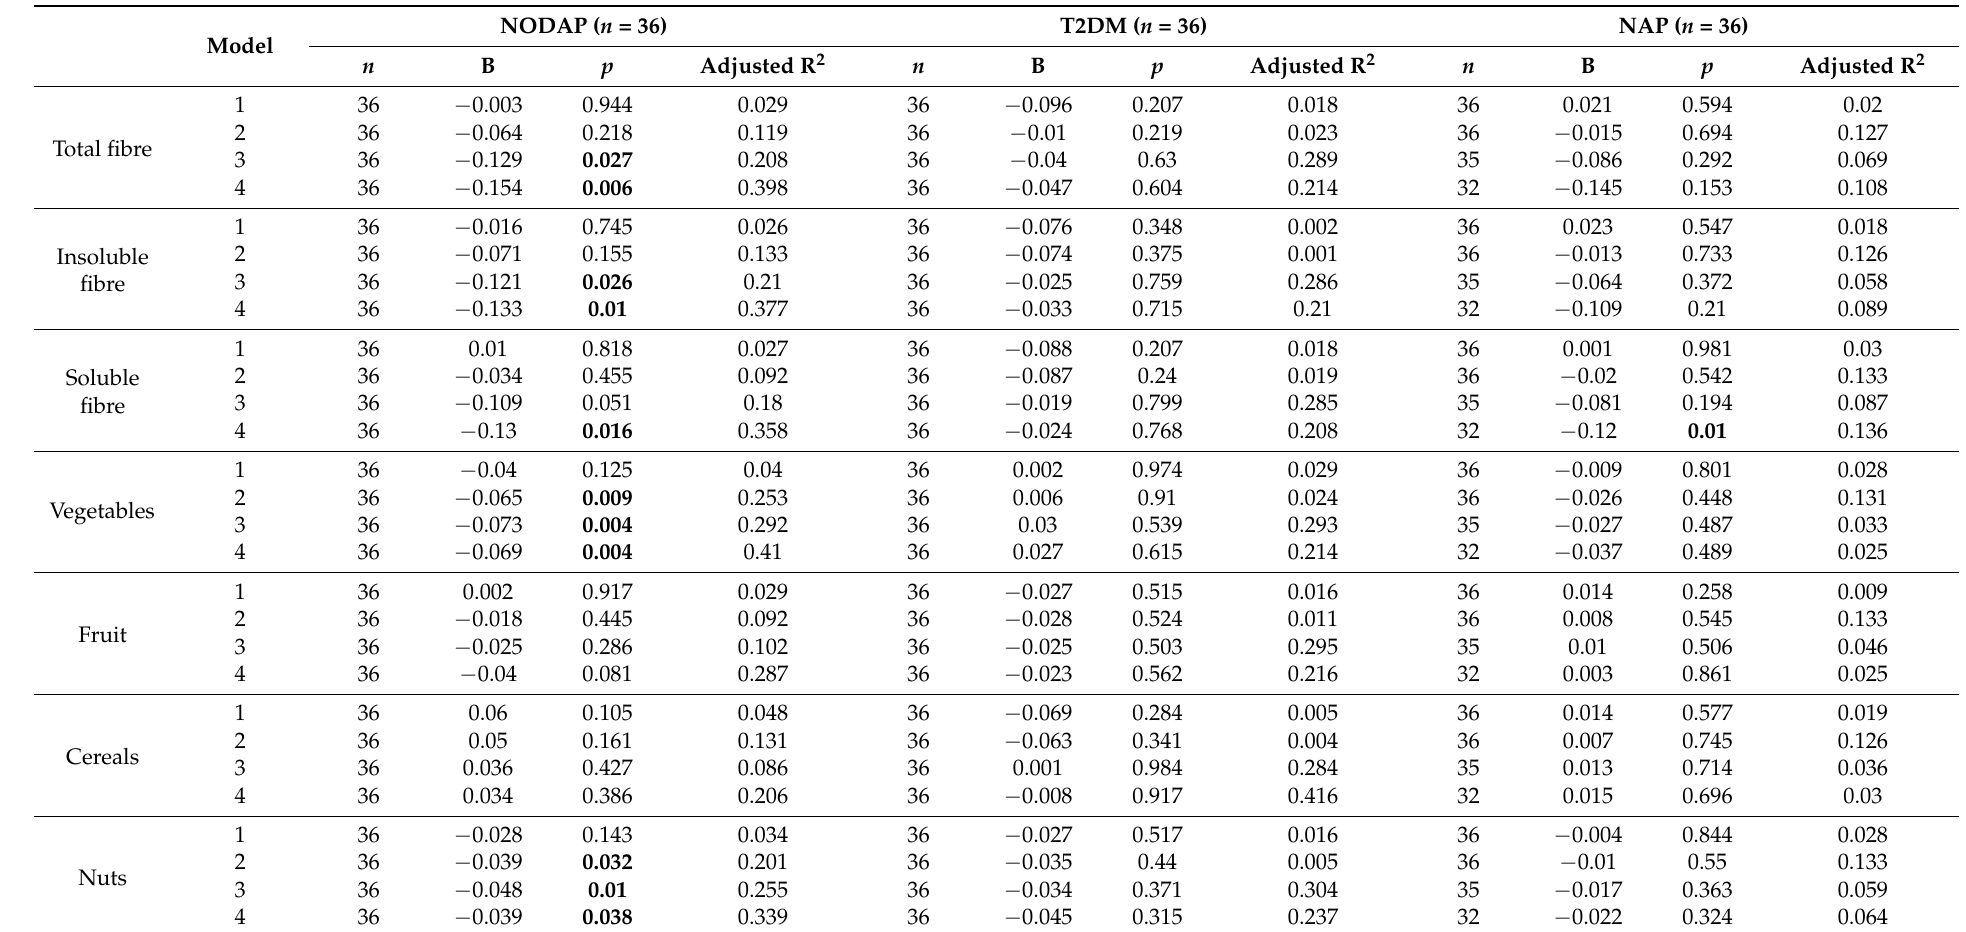
Table 2. Associations between dietary fibre intake and fasting plasma